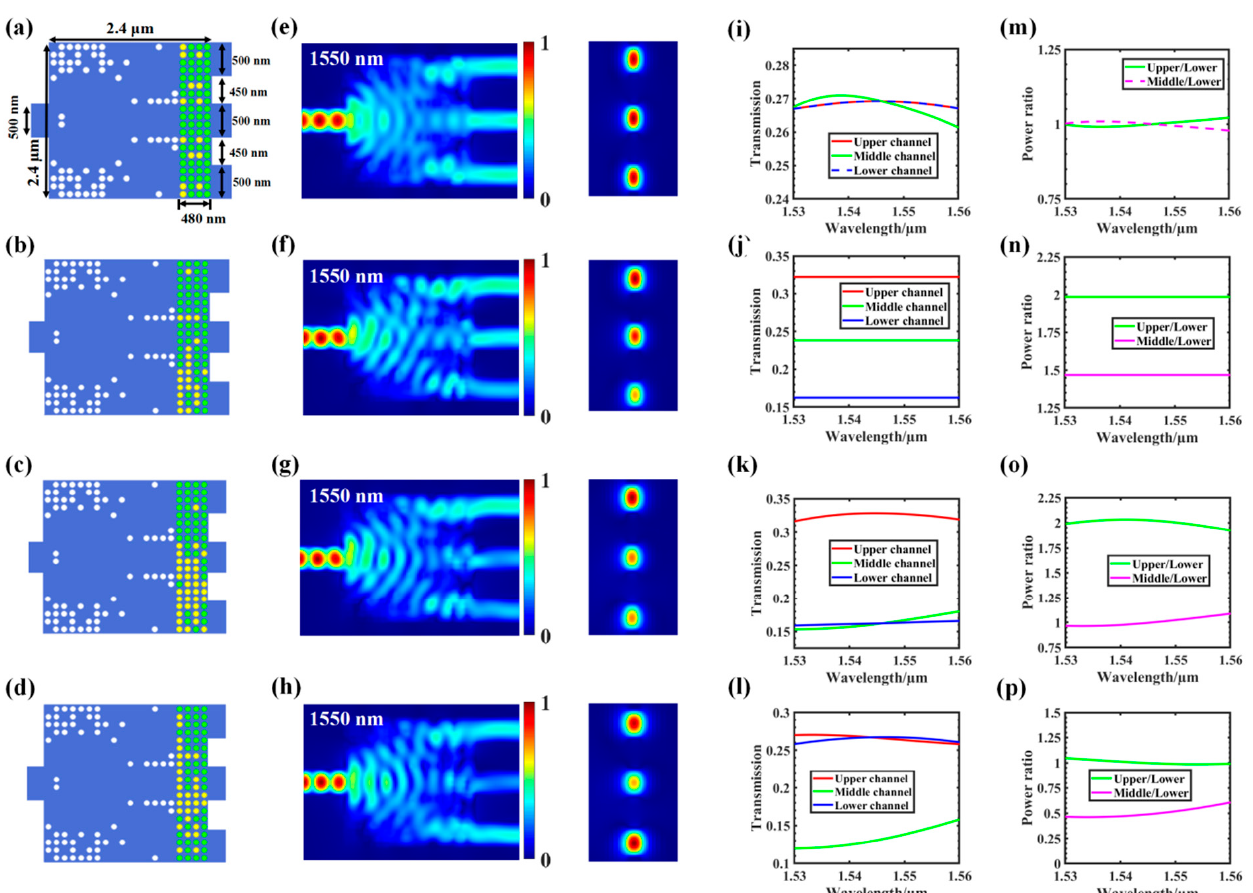
Figure 7. Design of a three-channel adjustable programmable power splitter: ( a – d ) structure diagram of a 1 × 3 power splitter with 1:1:1, 2:1.5:1, 2:1:1, and 2:1:2 split ratios; ( e – h ) light field distribution at 1550 nm of the upper, middle, and lower channels; ( i – l ) transmission spectra of all tested channels; ( m – p ) simulated power–split ratio for the 1 × 3 splitter, where the green line indicates the simulated power ratio between the upper and lower channels in the wavelength range of 1530–1560 nm. The purple line indicates the ratio between the middle and lower channels.